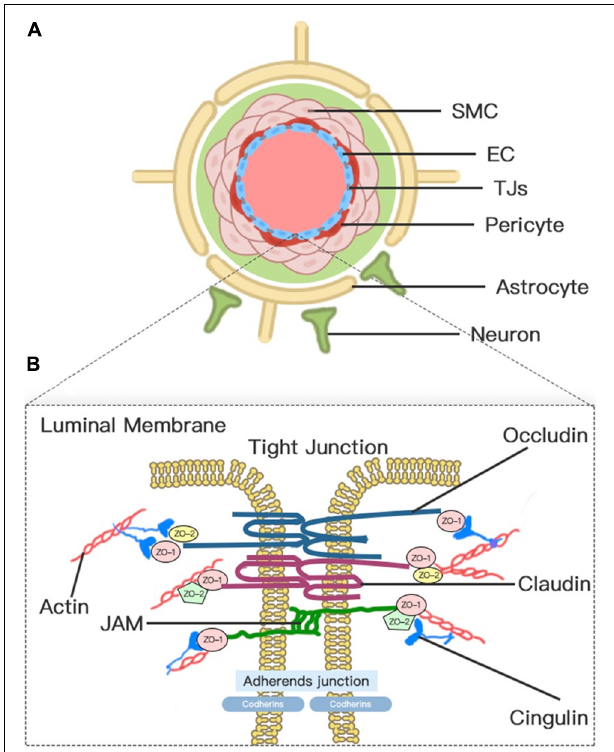
FIGURE 1 | Neurovascular unit (NVU) and blood–brain barrier (BBB). (A) Transverse-section representation of the NVU. The concept of the NVU highlights the importance of the intimate interactions between components of the BBB and cells in brain parenchyma, including pericytes, astrocytes, microglia, and neurons. The BBB is centrally positioned within the NVU, which is formed by a monolayer of endothelial cells sealed by tight junctions. (B) A schematic blow-up of the tight junctions (TJs) and adherens junctions (AJs) at the BBB as defined in the